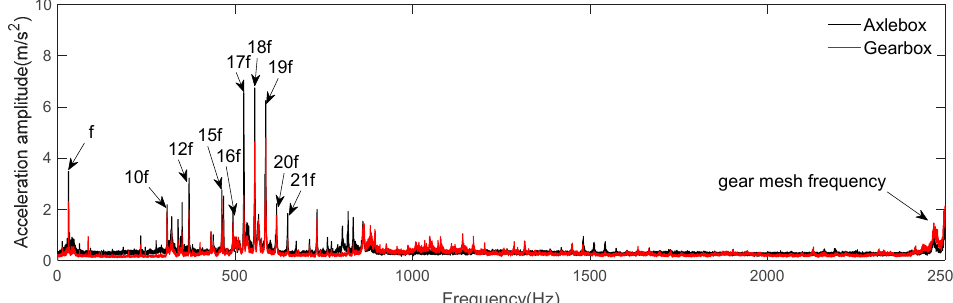
Figure 7. Vibration of gearbox and axle box.